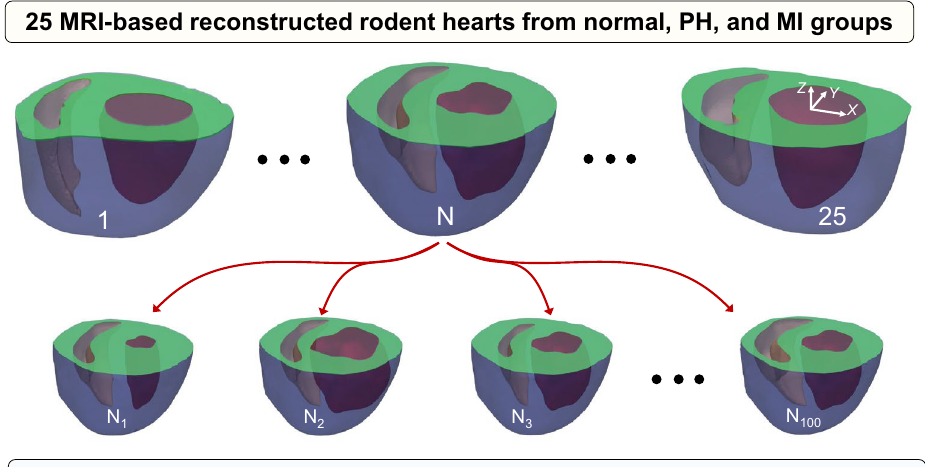
Figure 3. Creation of partially synthetic heart geometries using MRI-based reconstructed biventricular hearts.